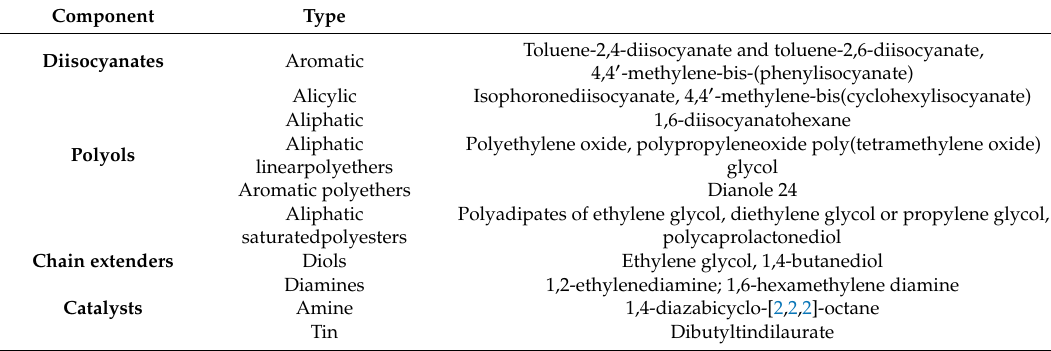
Table 1. Usual components of PUs